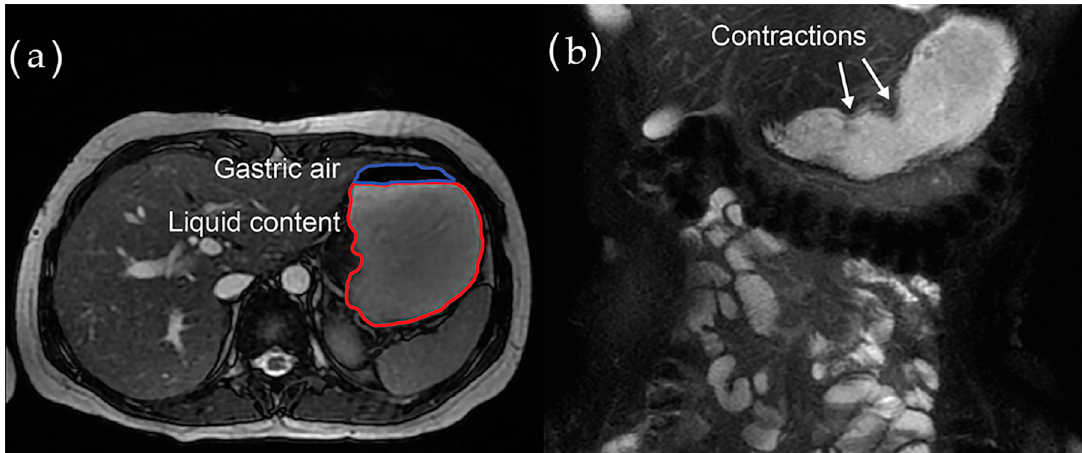
Figure 4. Magnetic resonance imaging of the stomach. ( a ) Gastric air volume and liquid content volume obtained in the segmentation process. ( b ) Contraction waves observed and quantified in the coronal plane.